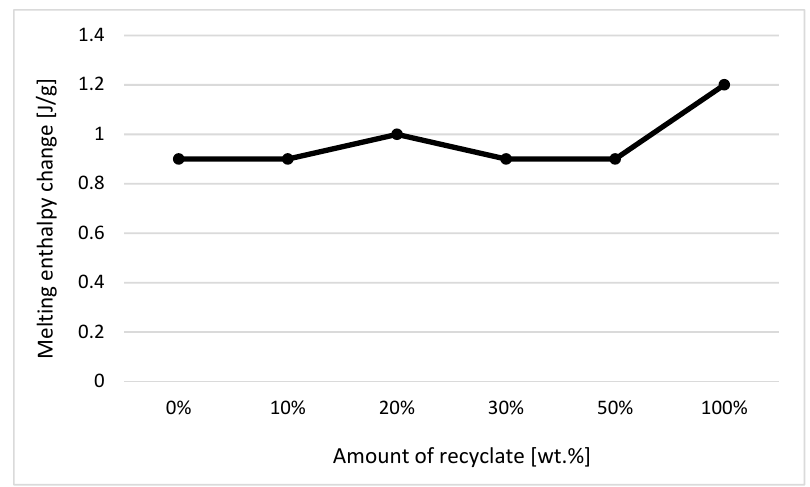
Figure 1. Dependence of the change in melting enthalpy on the proportion of weight of the recycled material before exposure of the samples to elevated temperature—component 1.